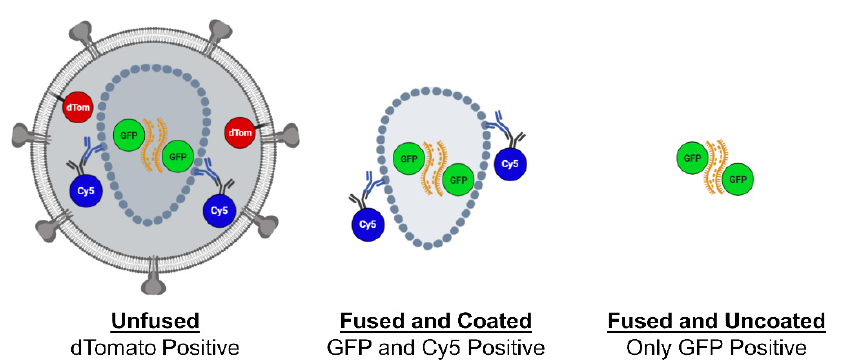
Figure 1. Schematic of dual-labelled HIV-1. Dual-labelled virus used in the in situ uncoating assay can include various combinations of fluorophore signal. Pre-fusion virus is expected to appear dTomato-positive. Post-fusion the dTomato signal is shed, while GFP and Cy5 signal remains. Loss of capsid is identified based on GFP-positive but Cy5-negative punctate. Image created with Bio- render.com.